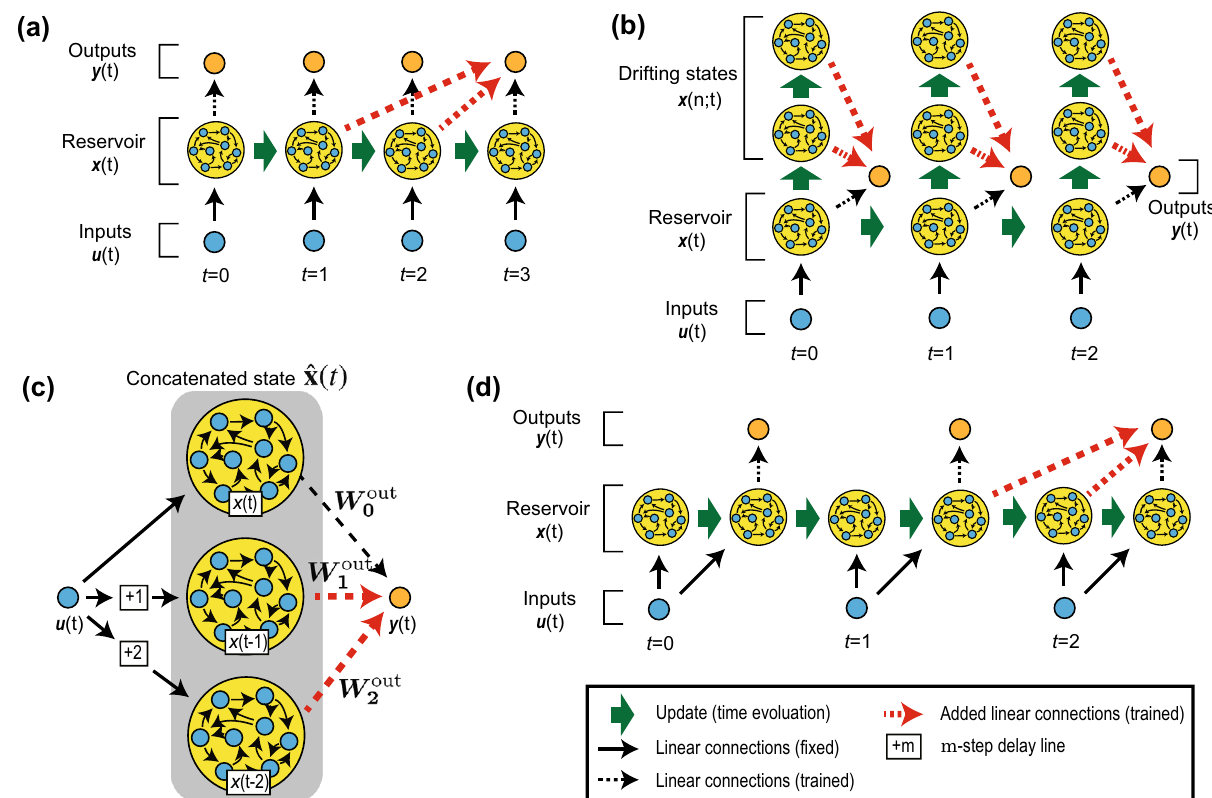
Figure 2. Schematics of the proposed methods. ( a ) Delay-state concatenation when the number of additional connections P is two and the unit of delay Q is one. ( b ) Drift-state concatenation when P is two and Q is one. ( c ) Another view of delay-state concatenation. The reservoir consists of three identical dynamical systems and delay lines. The added dynamical systems have + 1 delay lines and + 2 delay lines, respectively. ( d ) Delay-state concatenation with one transient state when P is two and Q is